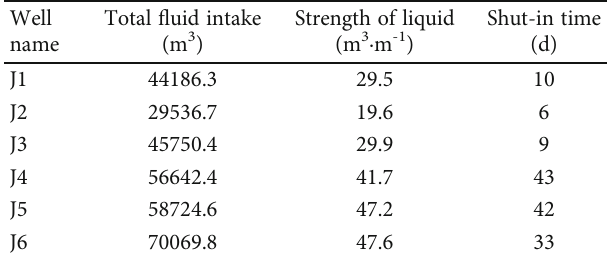
Figure 13: Recovery of di ff erent imbibition additives. Table 1: Well J1 – J6 fracturing